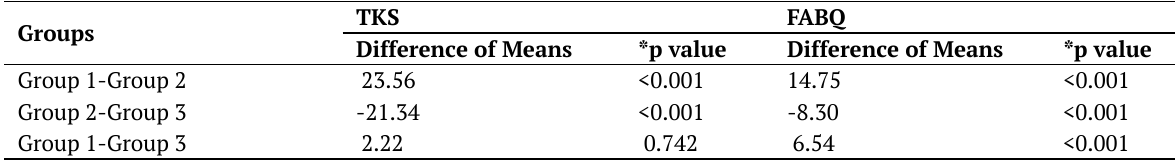
Table 3. Pairwise comparisons between groups Groups